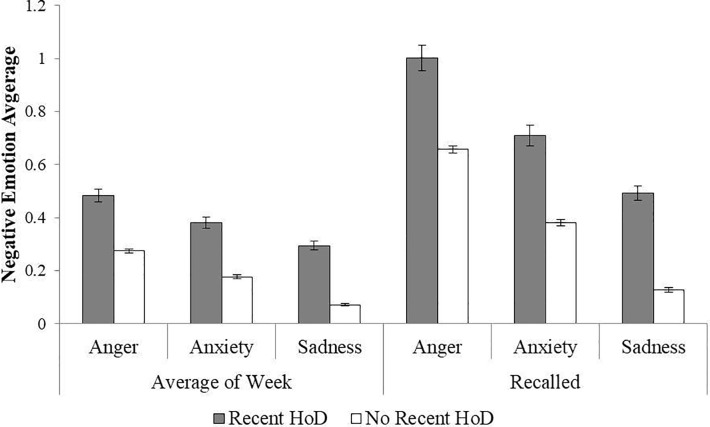
Negative clusters by recent history of depression.Note. Error bars represent standard error values. HoD = History of Depression. The model is adjusted for gender and evaluated at the following values: Age = 56.67, Education = 7.39.